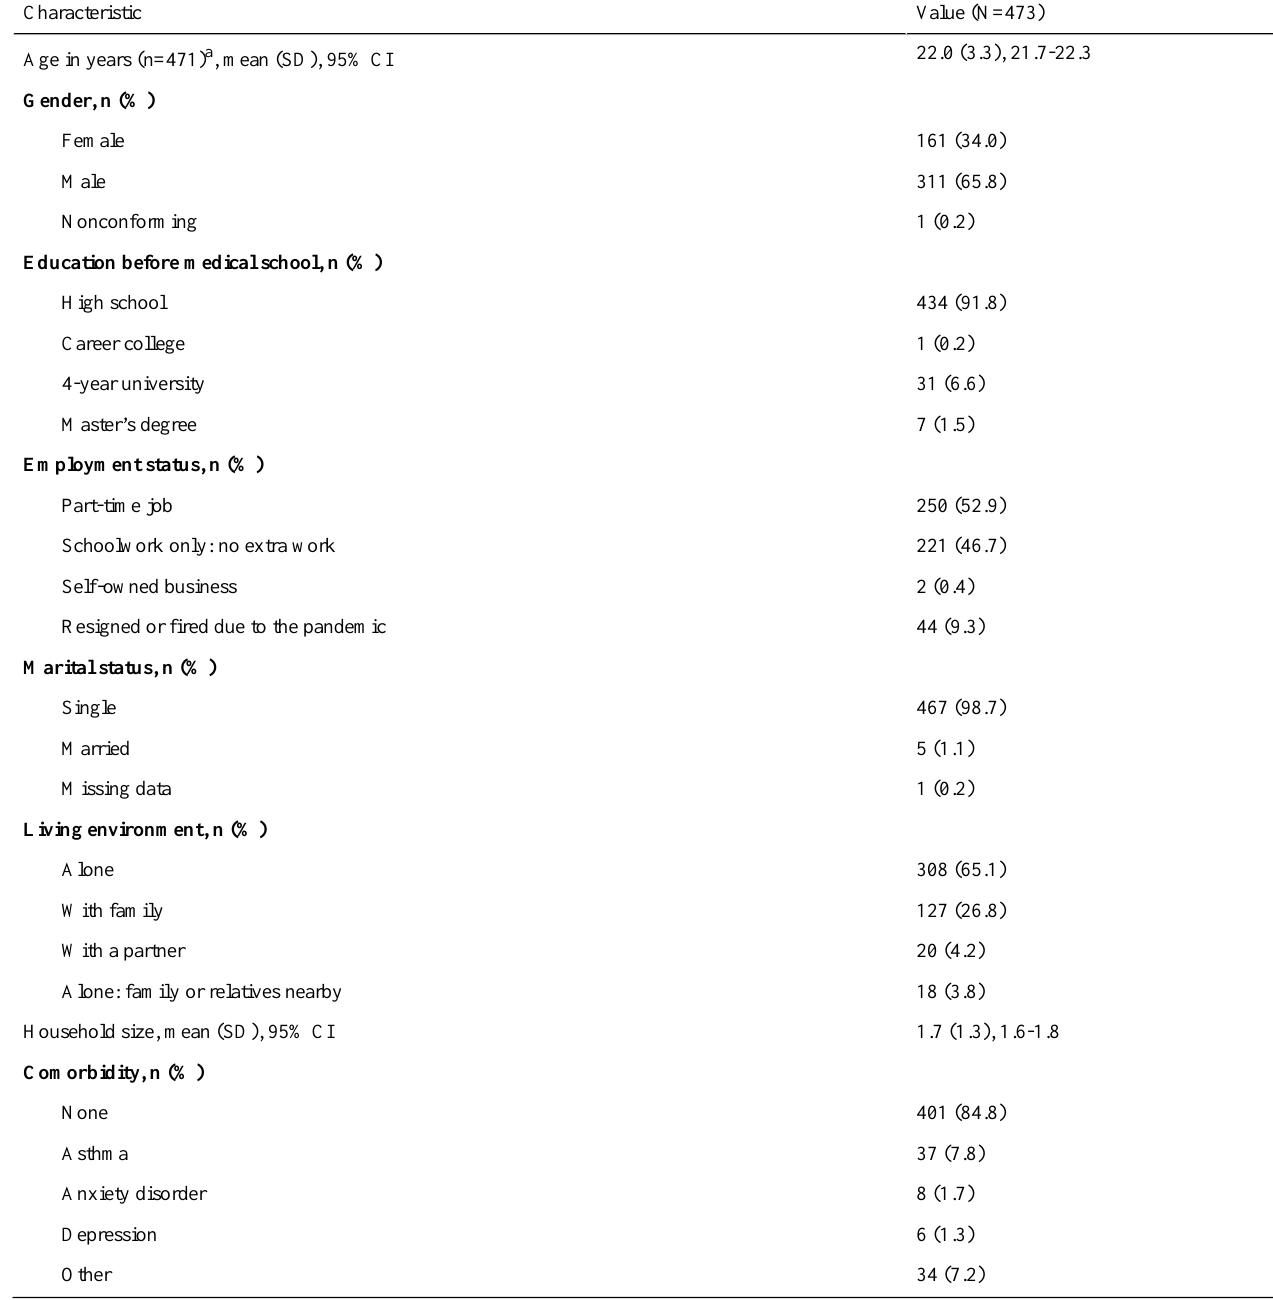
Table 1. Demographic characteristics of the study